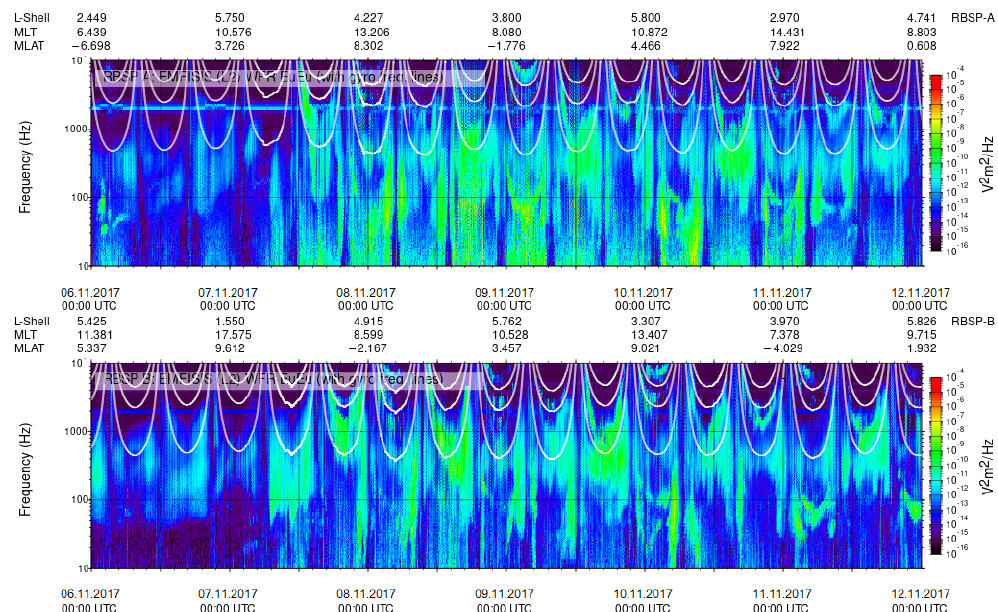
Figure 6. RBSP E-field measurements by EMFISIS